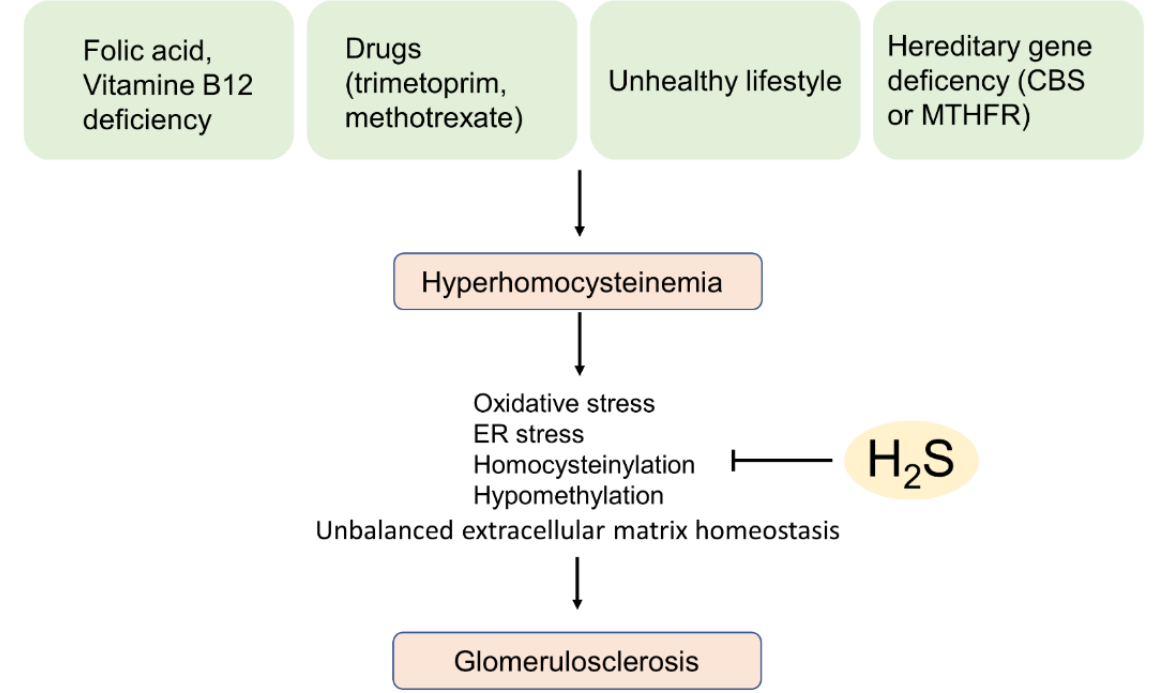
Figure 4. H 2 S attenuates hyperhomocysteinemia-induced glomerulosclerosis. H 2 S reduces symptoms hyperhomocysteinemia such as oxidative stress and ER-stress. CBS, cystathionine- β -synthase; ER stress, endoplasmic reticulum stress; MTHFR, methylenetetrahydrofolate reductase.